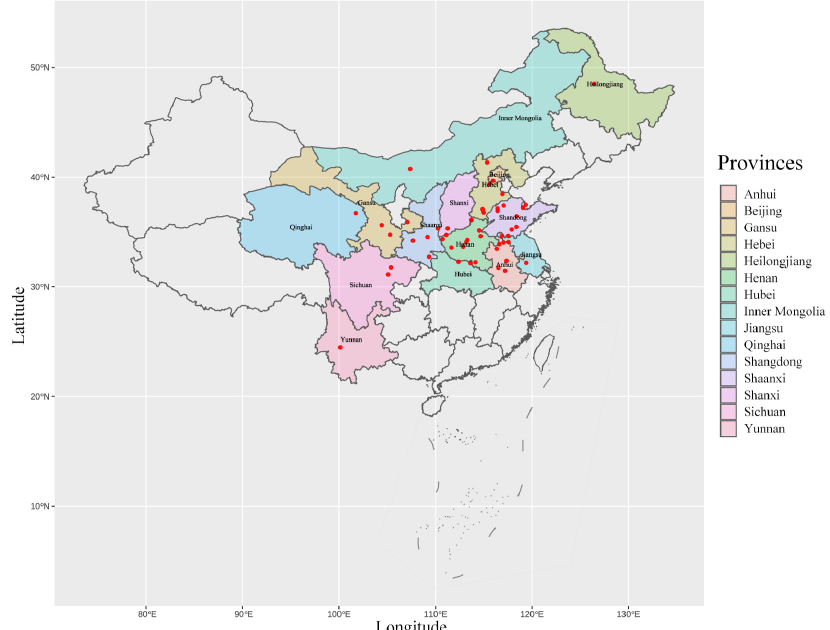
Figure 1. The collection site of Pt samples collected from 15 provinces in China in 2018, red dots represent sample collection sites.